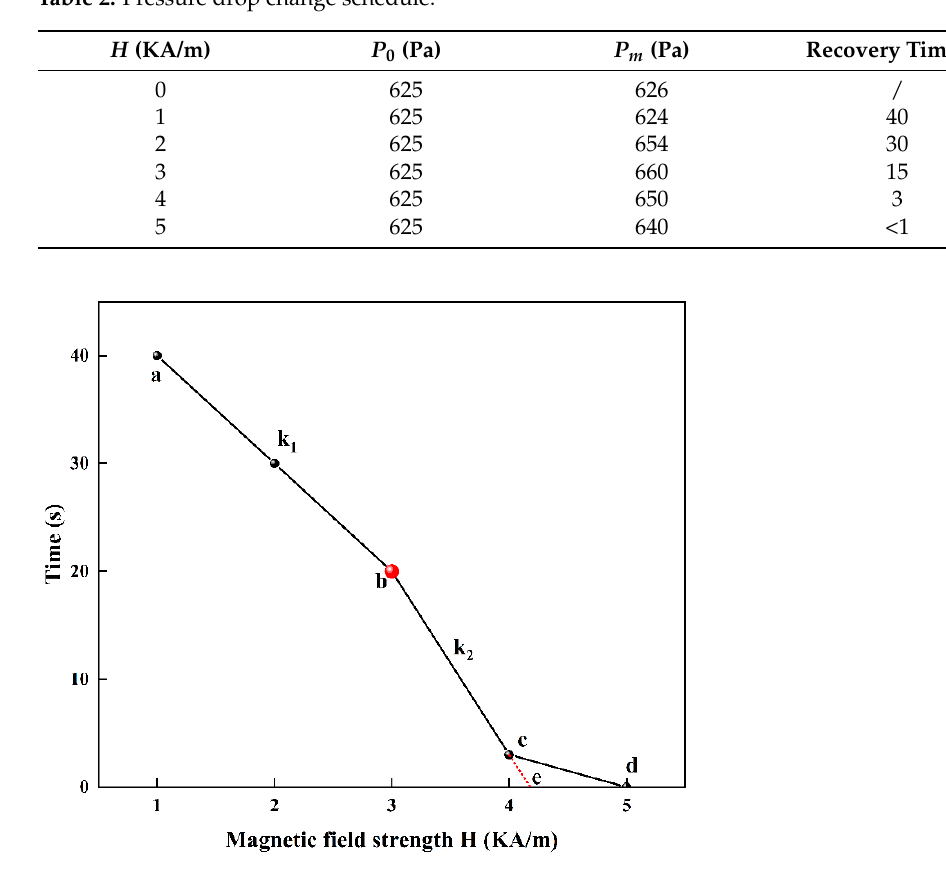
Figure 7. Pressure drop yield time of ‘adding magnetic field later’. ( a–d), are experimental values and e is the predicted value. k 1 is the slope of the ab line, k 2 is the slope of the bc line, and the abso- lute value of k 2 is greater than the absolute value of k 1